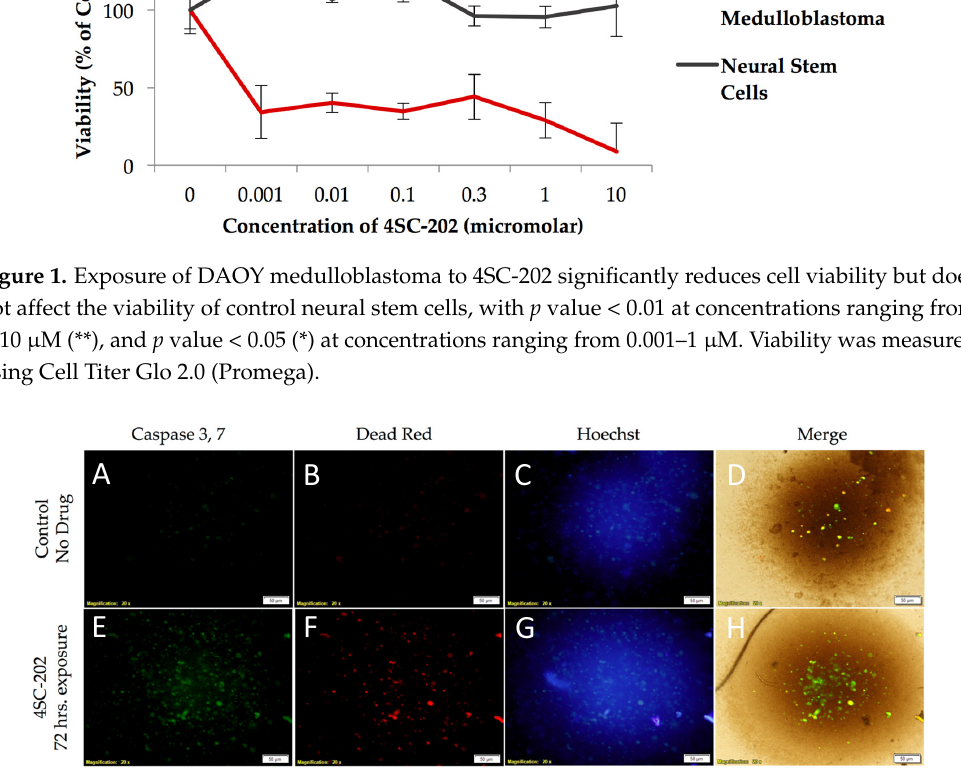
Figure 2. 4SC-202 induces caspase-3/7 activities in DAOY spheroids. DAOY spheroids were treated with 4SC-202 for 72 h. Prior to being stained with caspase-3/7, Dead Red, and Hoechst stains. Caspase-3/7 activities are present in spheroids treated with 4SC-202 ( E ) but absent in DMSO control-treated spheroids ( A ). Increased dead cells were observed in the 4SC-202-treated spheroid ( F ) compared to DMSO control-treated spheroids ( B ). Hoechst stain visualizes nuclei in both conditions ( C , G ). Increased colocalization of caspase-3/7 with dead cells is visualized in ( H ) as compared to ( D ). Scale bar = 50 microns.